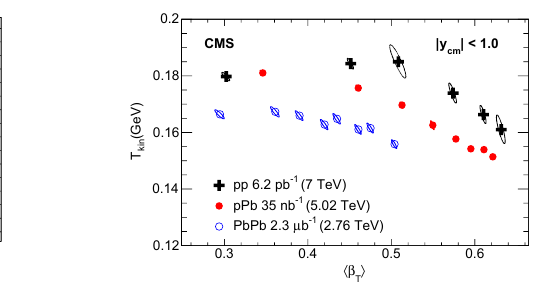
Figure 5. Left: the v 2 results of inclusive charged particles, K 0 multiplicity in pp collisions, after correcting for back-to-back jet correlations estimated from low-multiplicity data [16]. Right: the extracted kinetic freeze-out temperature, T kin , versus the average radial-flow velocity, from a simultaneous blast-wave fit to the K 0 pPb , and PbPb collisions